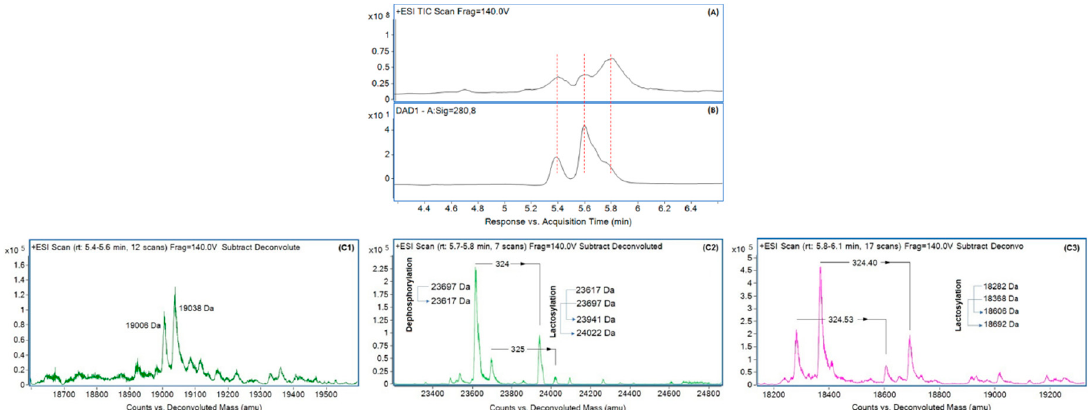
Figure 5. Results of liquid chromatography-mass spectrometry; (A) UV chromatogram of proteins in concentrated milk, (B) total ion chromatogram of proteins in concentrated milk, (C) deconvoluted mass spectra of different proteins, peaks appear at retention time 5.4 min (C1), 5.6 min (C2), and 5.8 min (C3).